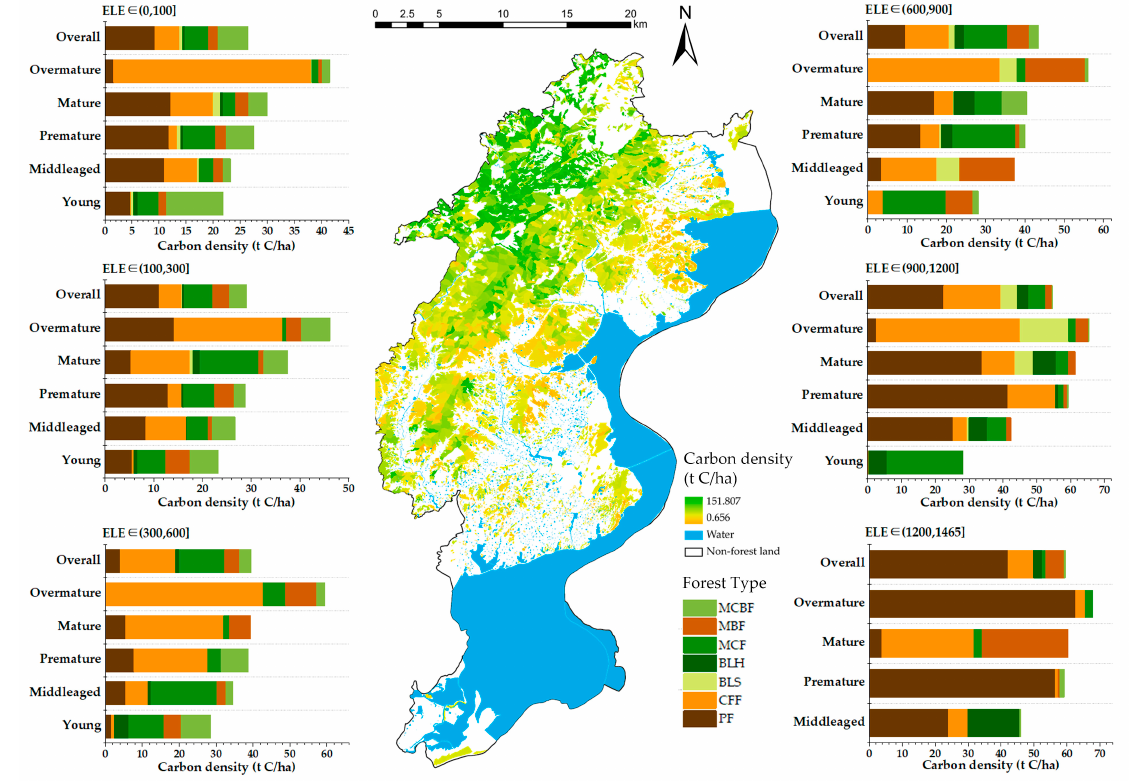
Figure 3. Characteristics of the current carbon sequestration capacity of forests in Lushan City. The carbon sequestration capacity of forests in Lushan City was calculated from four aspects: spatial distribution, elevation, age group, and forest types. The geographic distribution map in the middle shows the spatial distribution of carbon density of forests in 2019; the carbon density stacking figures on both sides show the carbon density share of each age group of forest types in Lushan City at Table 4. Status of carbon density/carbon stock in forest patches of different types.